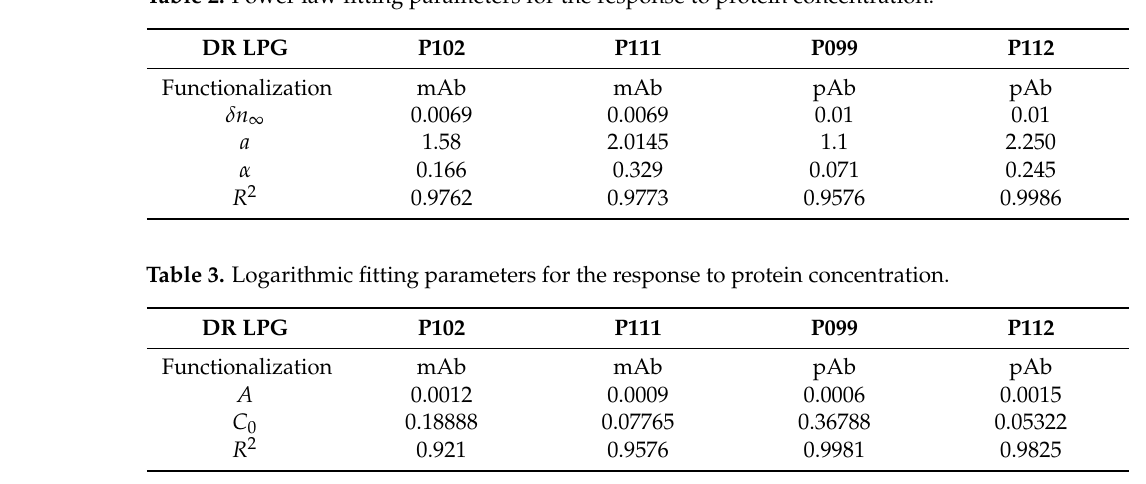
Figure 7. Composite results of responses to S and N proteins: ( a ) with mAb functionalization; ( b ) with pAb functionalization. Table 2. Power law fitting parameters for the response to protein concentration.